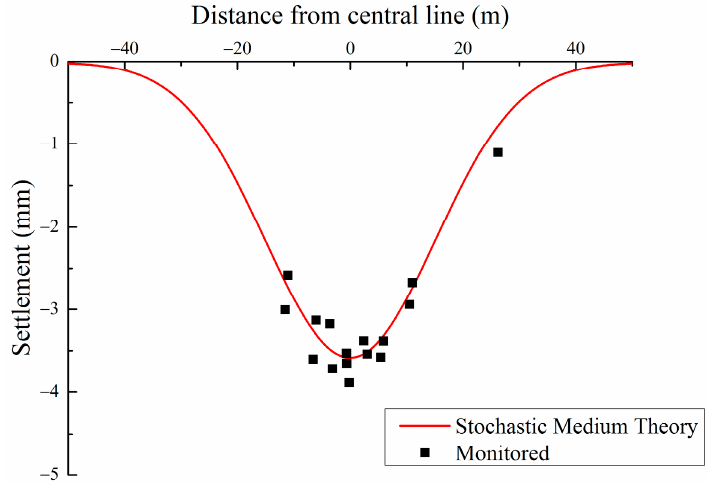
Figure 8. Comparison of the settlement between the stochastic medium theory and on-site monitoring. The settlement of the ground surface here is the difference in the monitored values before and after the tunnel excavation. The Trimble DiNi03 electronic level was adopted to measure the deformation of the ground surface, and the height measurement accuracy was 0.01 mm. The theoretical maximum settlement of the ground surface was 3.58 mm, and